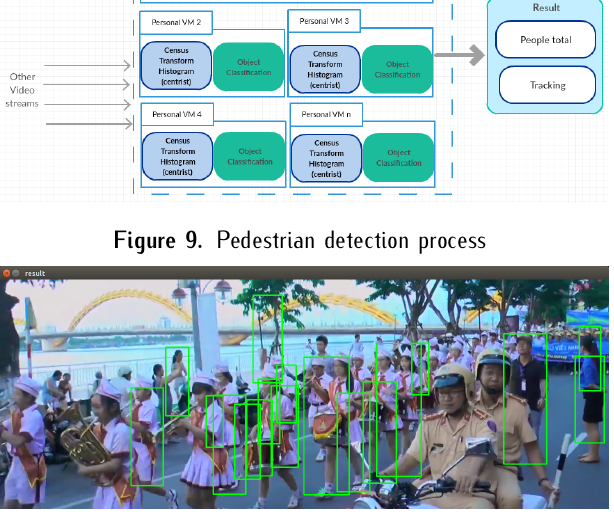
Figure 10. Pedestrian